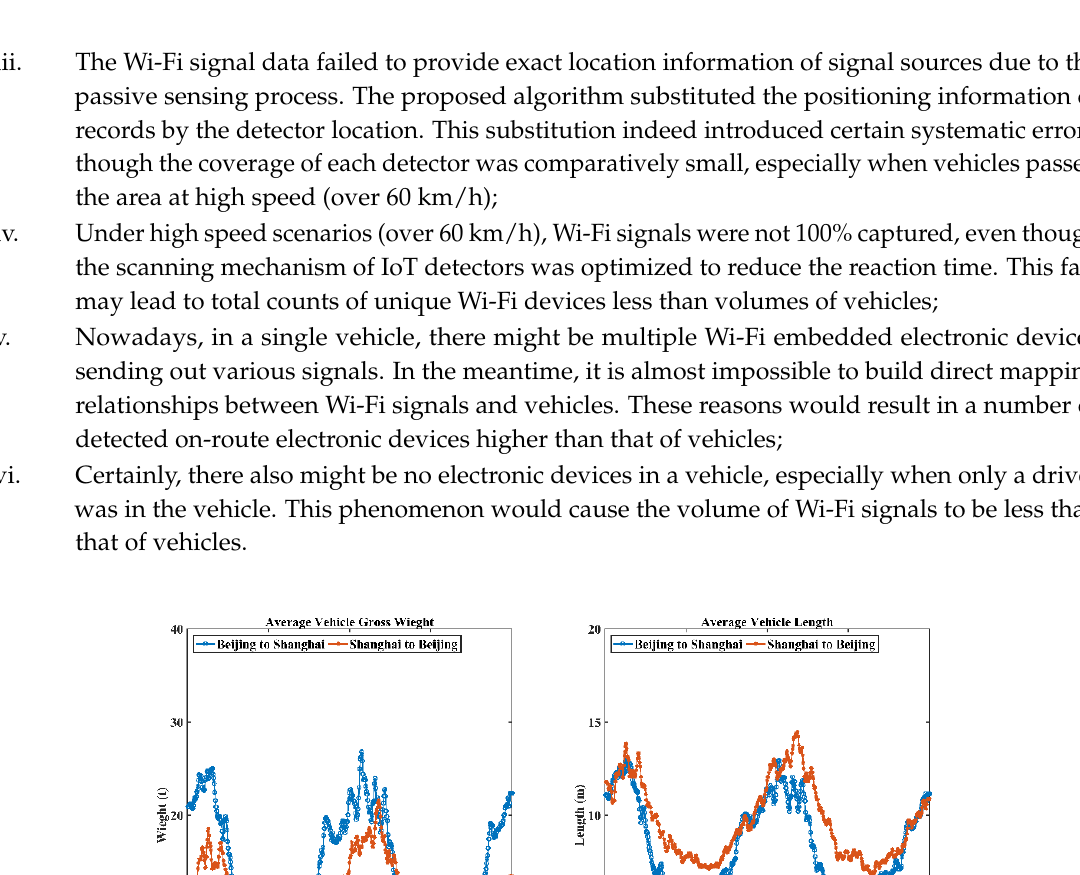
Table 3. Global volume error analysis for both directions.